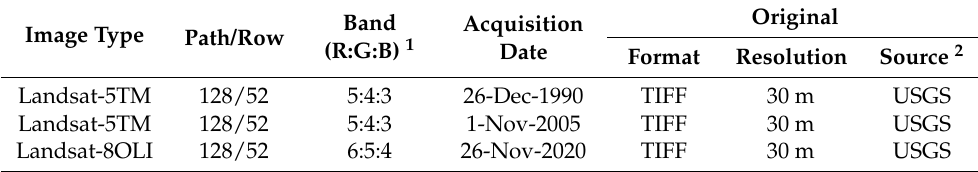
Table 1. Satellite image data covering Koh Chang area for LUC